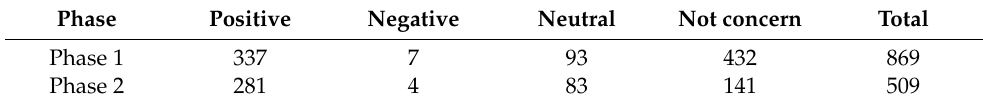
Table 3. Sentiments of posts and comments in two